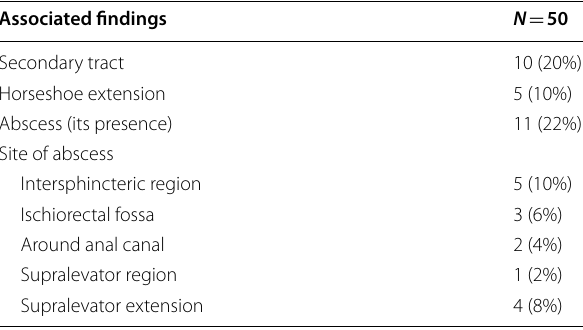
Table 8 Presence of secondary tract and abscess among enrolled patients